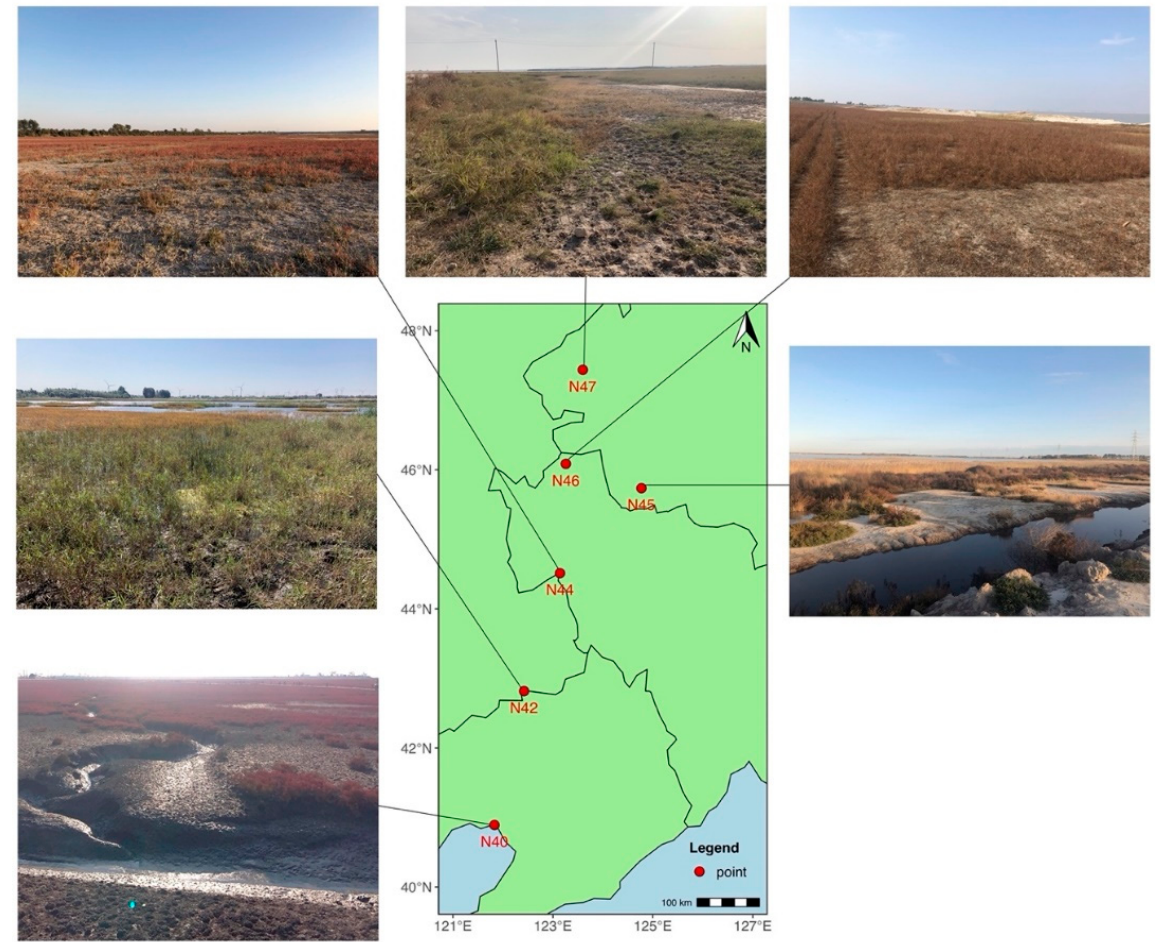
Figure 1. The map and profiles of the study area. Soil samples were collected from six sites (named N40, N42, N44, N45, N46, and N47, each representing the co-ordinates of the sampling site) across three provinces in Northeast China. The established study area consists of a 690-km south–north latitudinal gradient (40°53 ′ N to 47°26 ′ N).